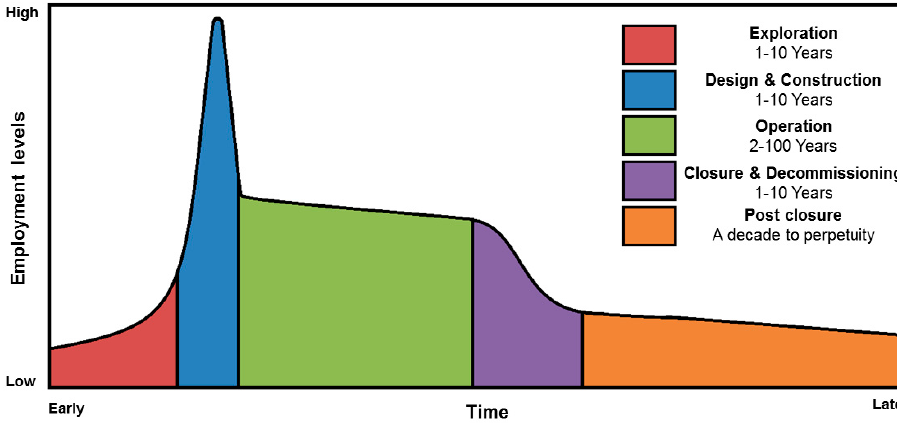
Figure 1. Employment opportunities in the lifecycle of a project (source: modified from Figure 1: Employment opportunities in the lifecycle of a project (source: modified from [131]).